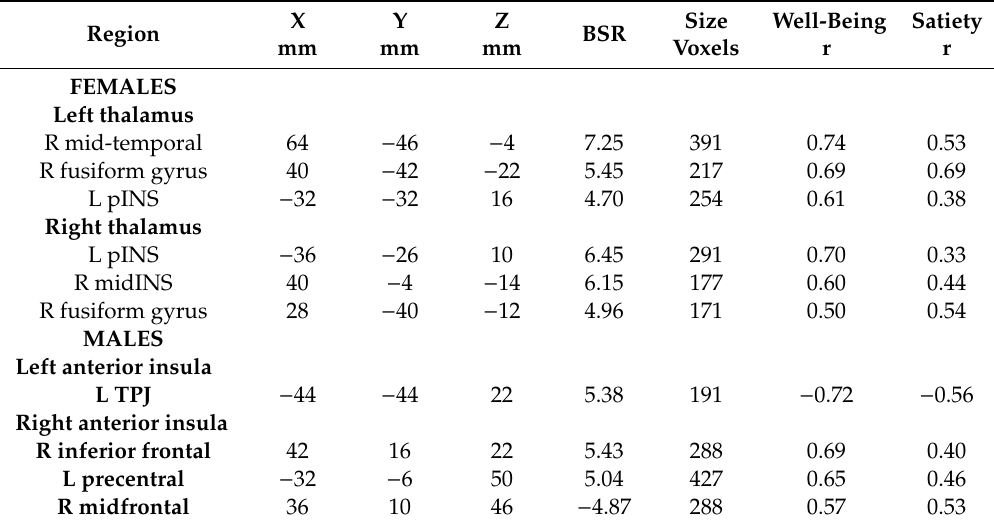
Table 2. Ingestion-related ROI connectivity changes correlated with change in perceptual